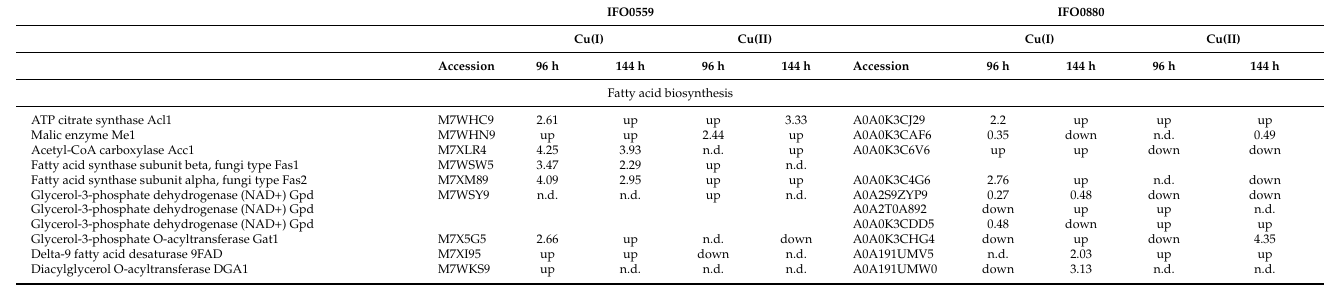
Table 5. Differentially expressed proteins involved in fatty acid biosynthesis discussed here. For IFO0559 and IFO0880, fold change of samples grown under Cu(I) and Cu(II) stress was compared to respective control. Protein names and UniProt accession numbers are listed. Abbreviations are written in bold. Further fold change at 96 h and 144 h of samples are stated. Fractions below 1 depict downregulation. n.d. = not detected; up = upregulated below cut-off score; down = downregulated below cut-off score. Cut-off score: significance ≤ 2 or fold change ≤